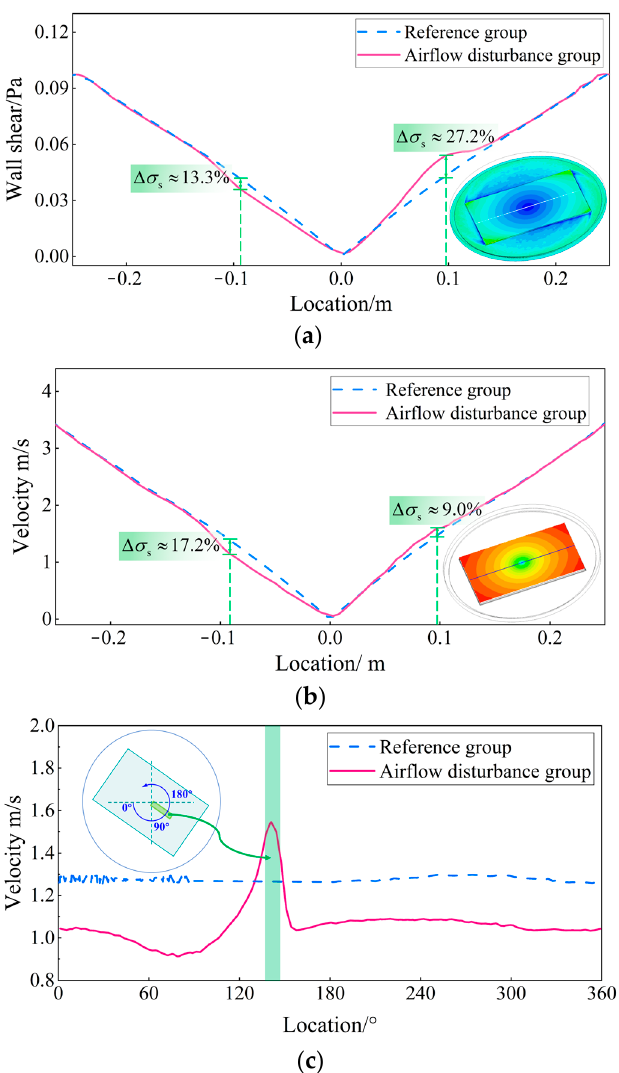
Figure 4. Characteristics of the chamber airflow field in the reference group and the airflow disturbance group. ( a ) the variety of velocity, ( b ) the variety of airflow shear stress, ( c ) the circumferential velocity fluctuation at the disturbance plate position. The height of the velocity field in ( a , c ) is 6 mm above the substrate. The data of flow velocity and wall shear in ( a , b ) was taken along the symmetry axis of the long side of the substrate.